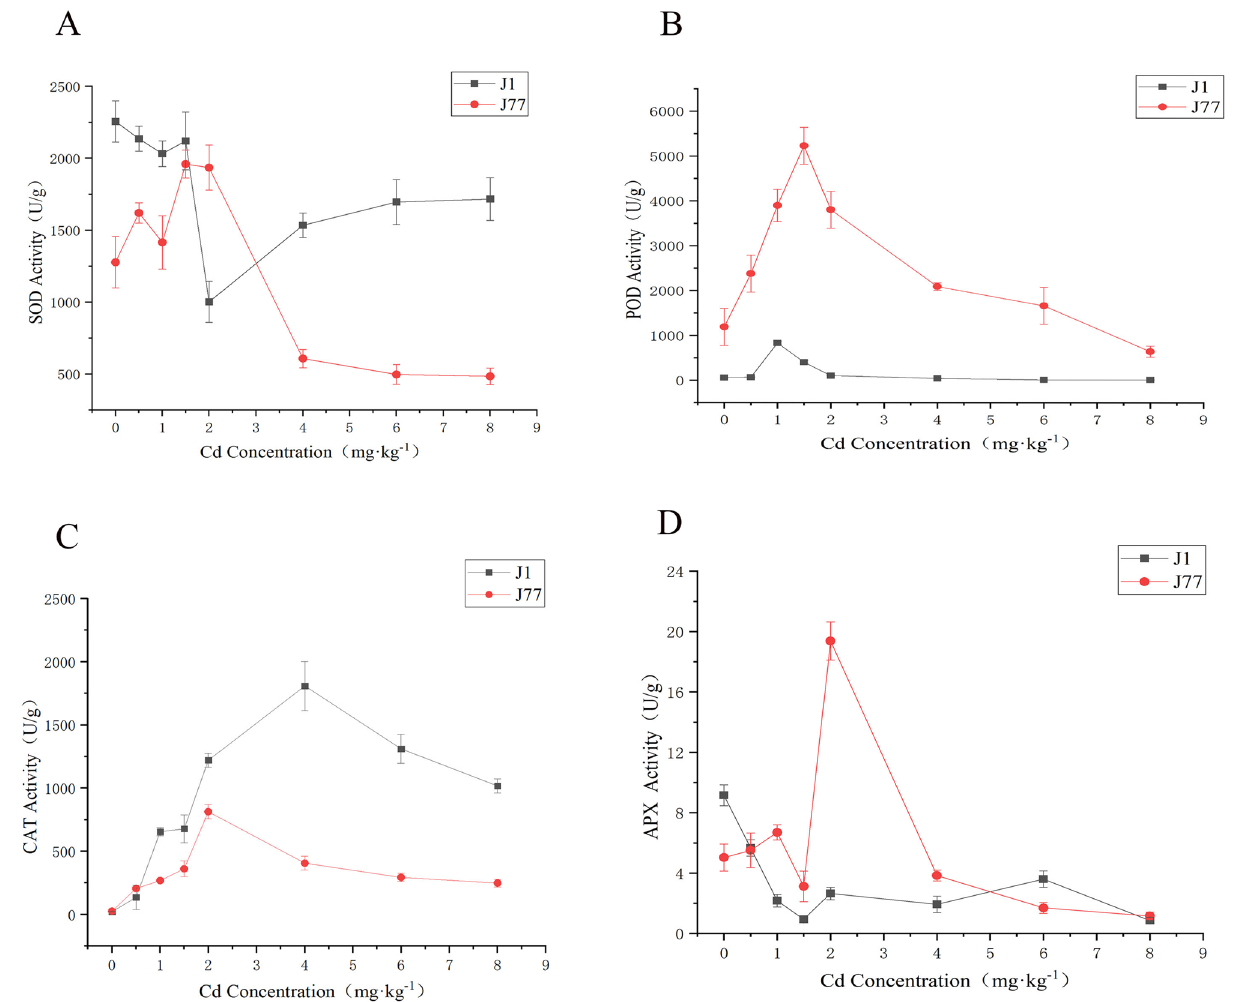
Figure 3. Effect of Cd stress on antioxidant enzyme activities.